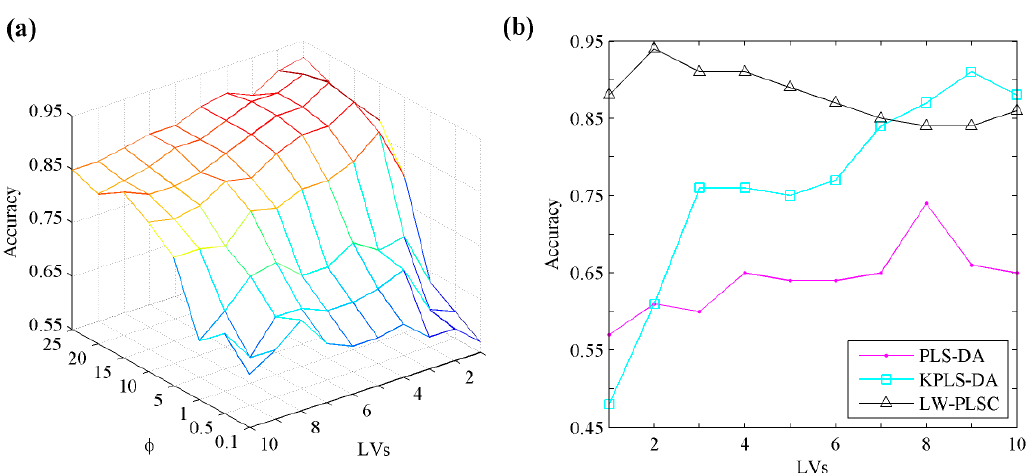
Figure 10. The accuracy of leave-one-out cross validation of LW-PLSC with varying parameters ( a ) and the performance of three PLS-based algorithms ( b ) on apple data.